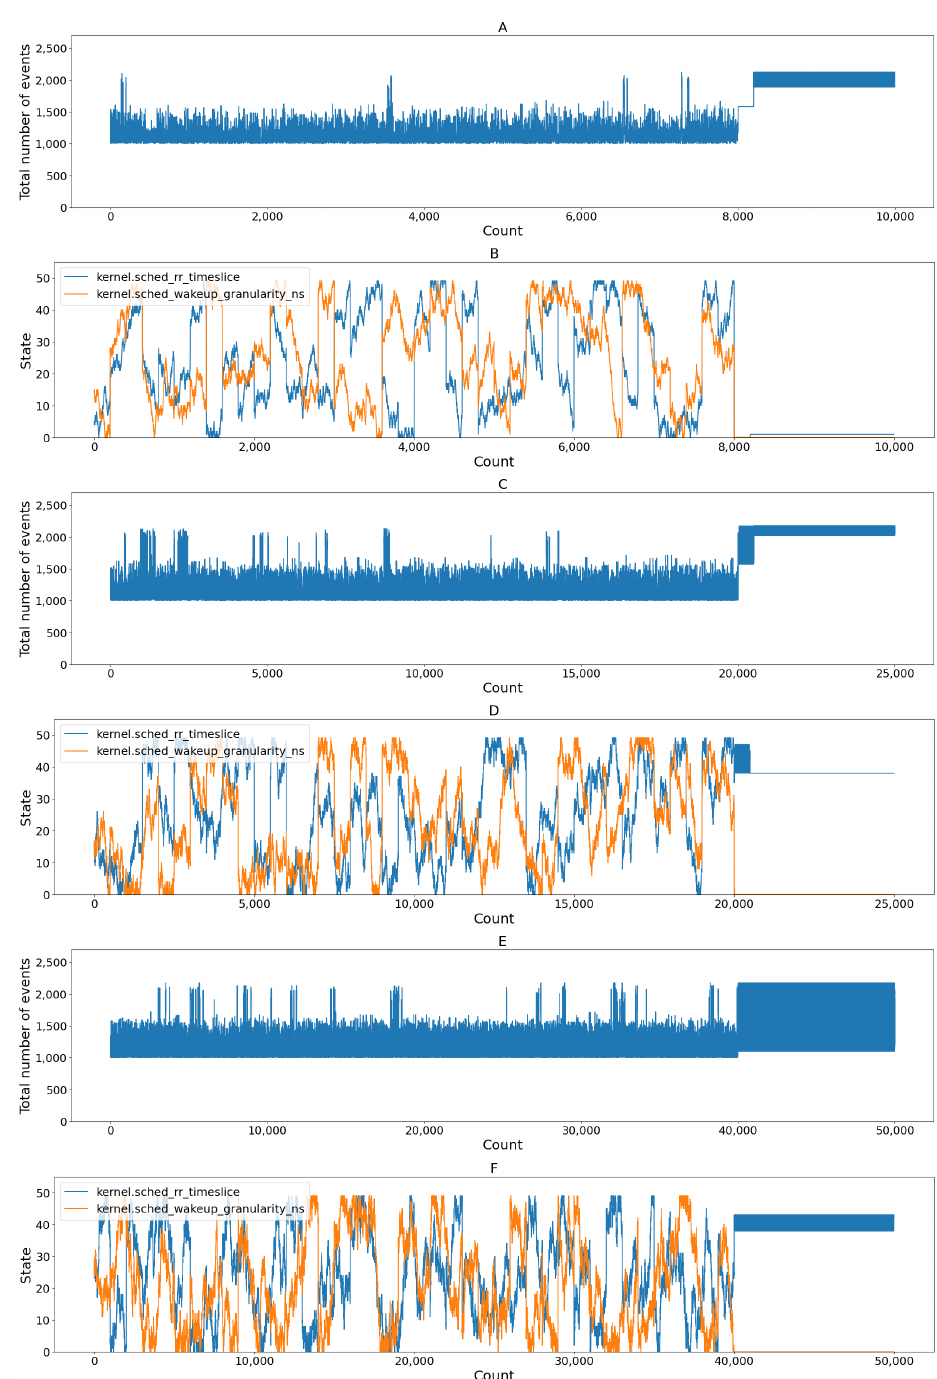
Figure 5. STUN performance according to the number of steps. The x-axis of each graph is the number of learning iterations. The y-axes of ( A , C , E ) represent the performance of Sysbench (the total number of events), and the y-axes of ( B , D , F ) represent the state values of each